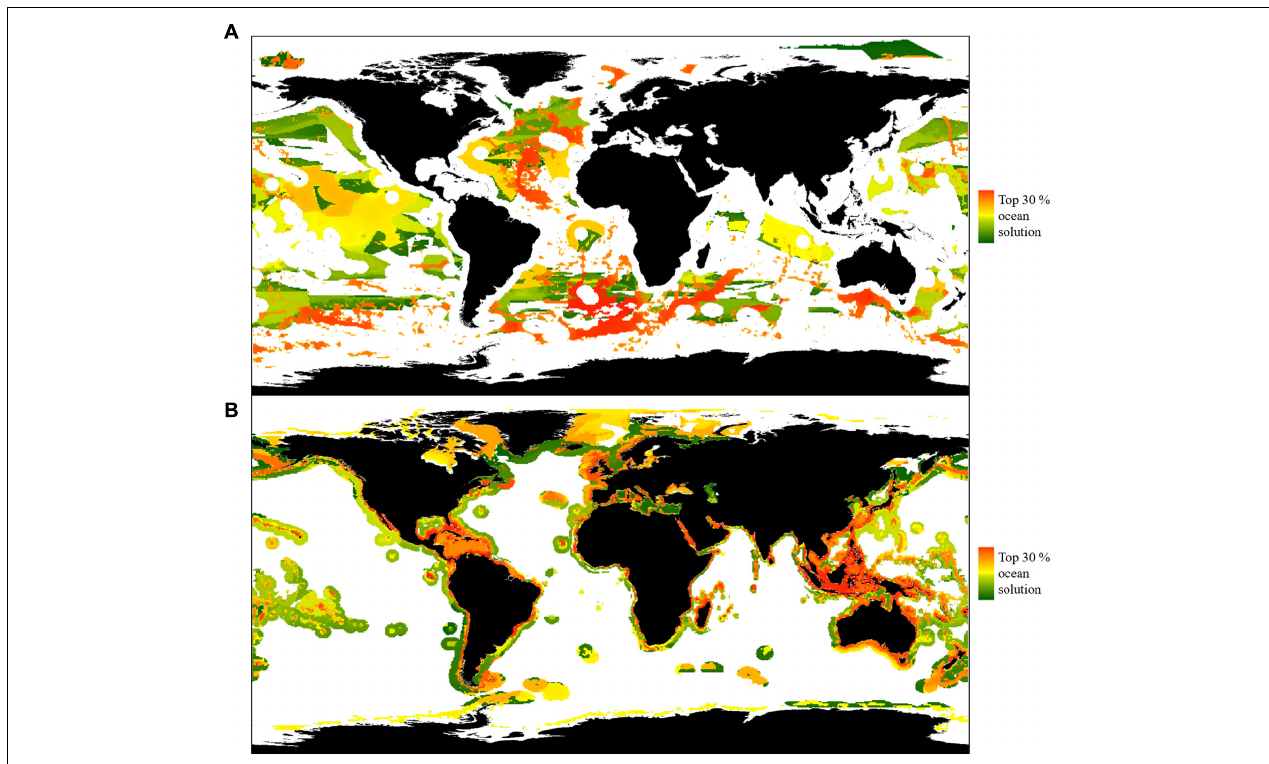
FIGURE 6 | Priority areas for protection covering 30% of the ocean in the High Seas and EEZs. Colour bars show areas of increasing priority per scenario (green to red). Panel (A,B) denotes (A) Scenario 4, protecting biodiversity and threatened species in the High Seas, and (B) Scenario 5, in